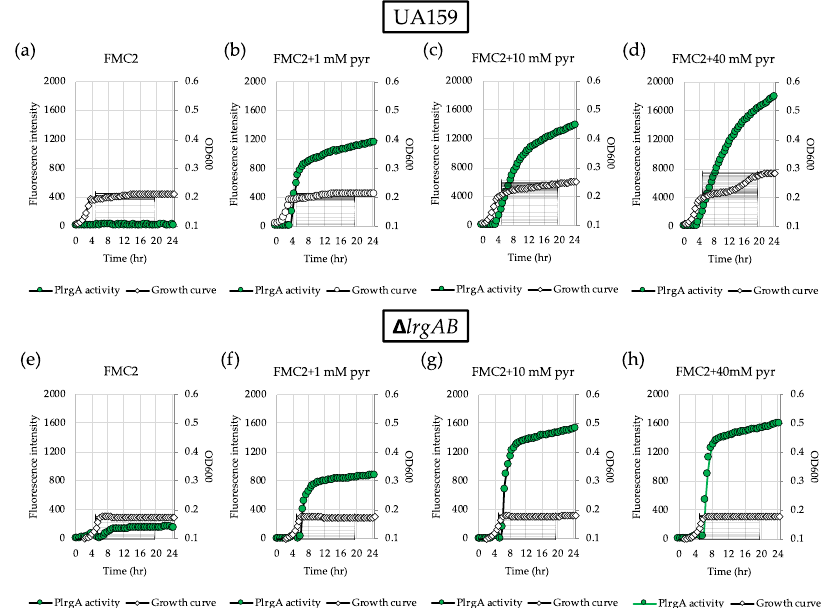
Figure 2. Change of P lrgA activity during growth of S. mutans UA159 wild type and ∆ lrgAB mutant strains in FMC2 medium, supplemented by di ff erent concentrations of extracellular pyruvate. For measurement of P lrgA activation, the P lrgA-gfp reporter strain in the wild type (top panel)